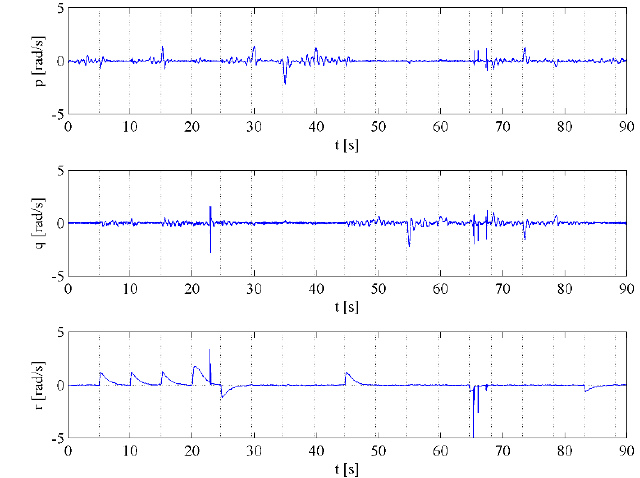
Figure 12. Angular velocity in E B (the body-fixed frame) of the quadrotor when using the PD controller.